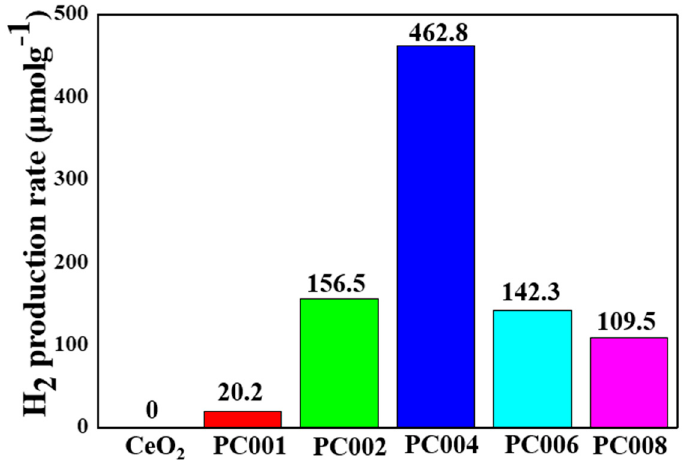
Figure 8. Hydrogen production efficiency by photocatalytic water splitting of the heterostructured CeO 2 /PANI powders as a function of the amount of PANI coating after 6 h of visible light irradiation.